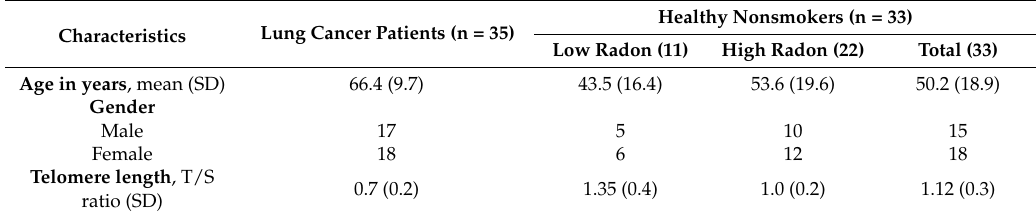
Table 1. Characteristics of the study